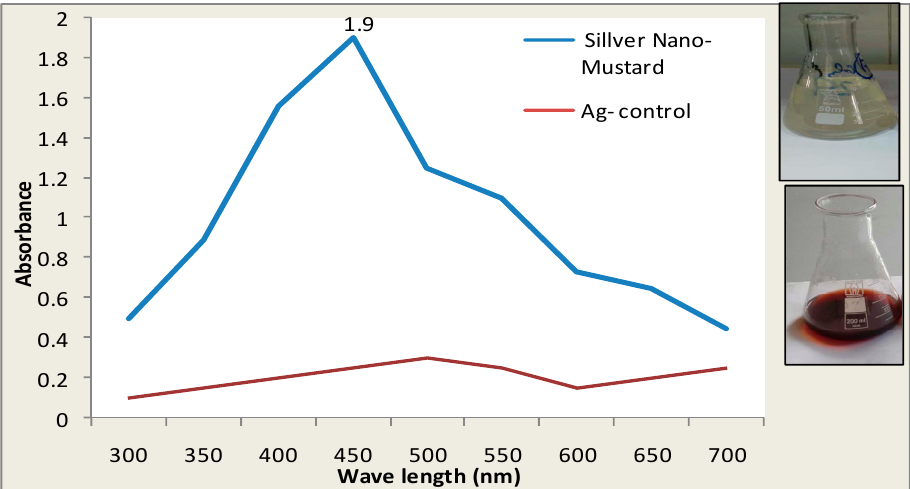
Figure 1. UV-visible spectrophotometric analysis of Ag mustard nanoparticles. Maximum absorption of Ag mustard nanoparticles at a wavelength of 425 nm.